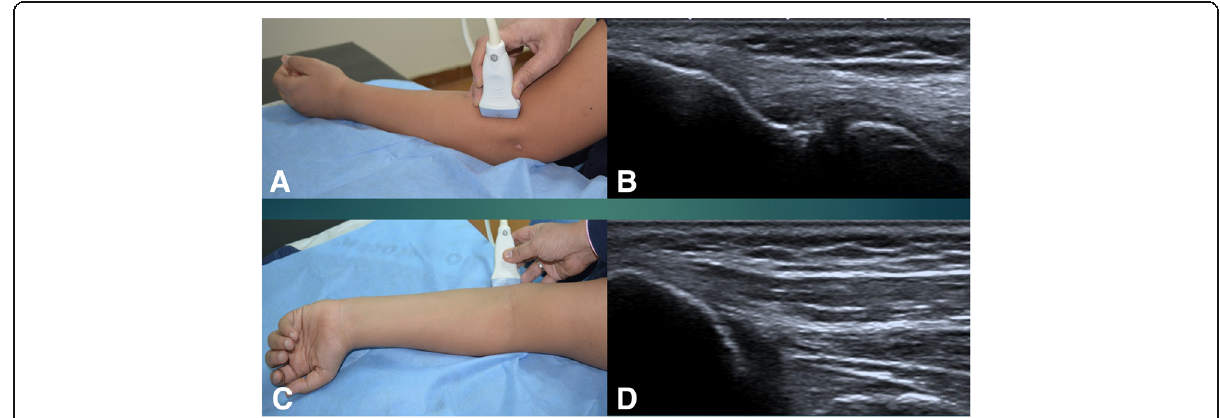
Fig. 2 Shows standard position and the corresponding US images, a : common extensor origin, b : corresponding US image for common extensor origin, c : common flexor origin, d : corresponding US image for common